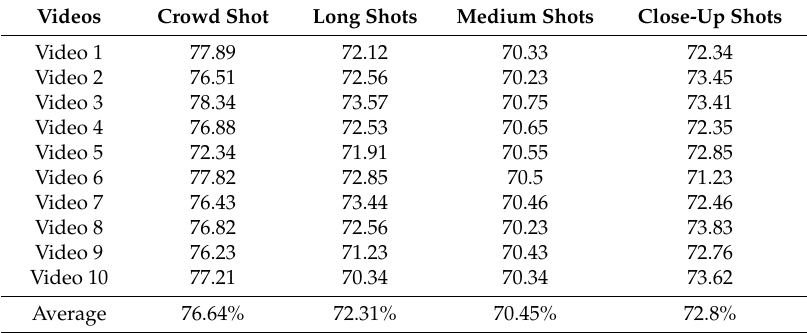
Table 3. Classification accuracy using SVM (linear kernel) with LBP features.